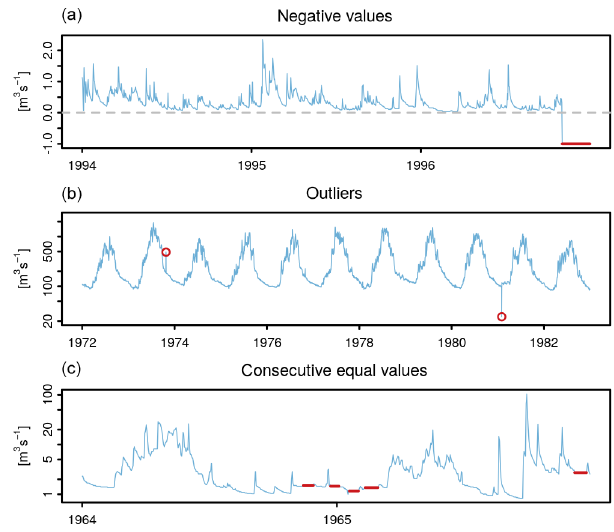
Figure 1. Three example time series illustrating issues detected by the three daily quality control criteria (highlighted in red). The first panel shows negative values at the end of the time series of Rohr at Rohrhardsberg, Germany. The second panel shows two outliers detected in the time series of Vakhsh at Gram, Tajikistan. The third panel shows instances of more than 10 consecutive equal values found in the time series of Tanara at Ponte di Nava, Italy. Note that all time series were trimmed for visualization purposes. Note also the logarithmic axis in panels two and